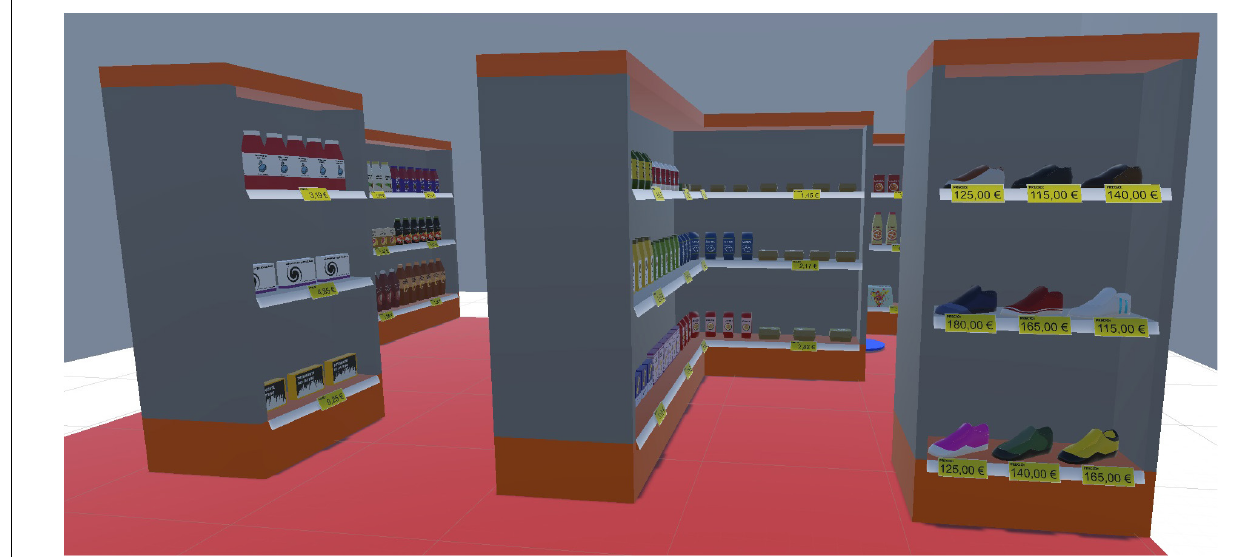
FIGURE 1 | Virtual store with seven shelves and three shelf levels.